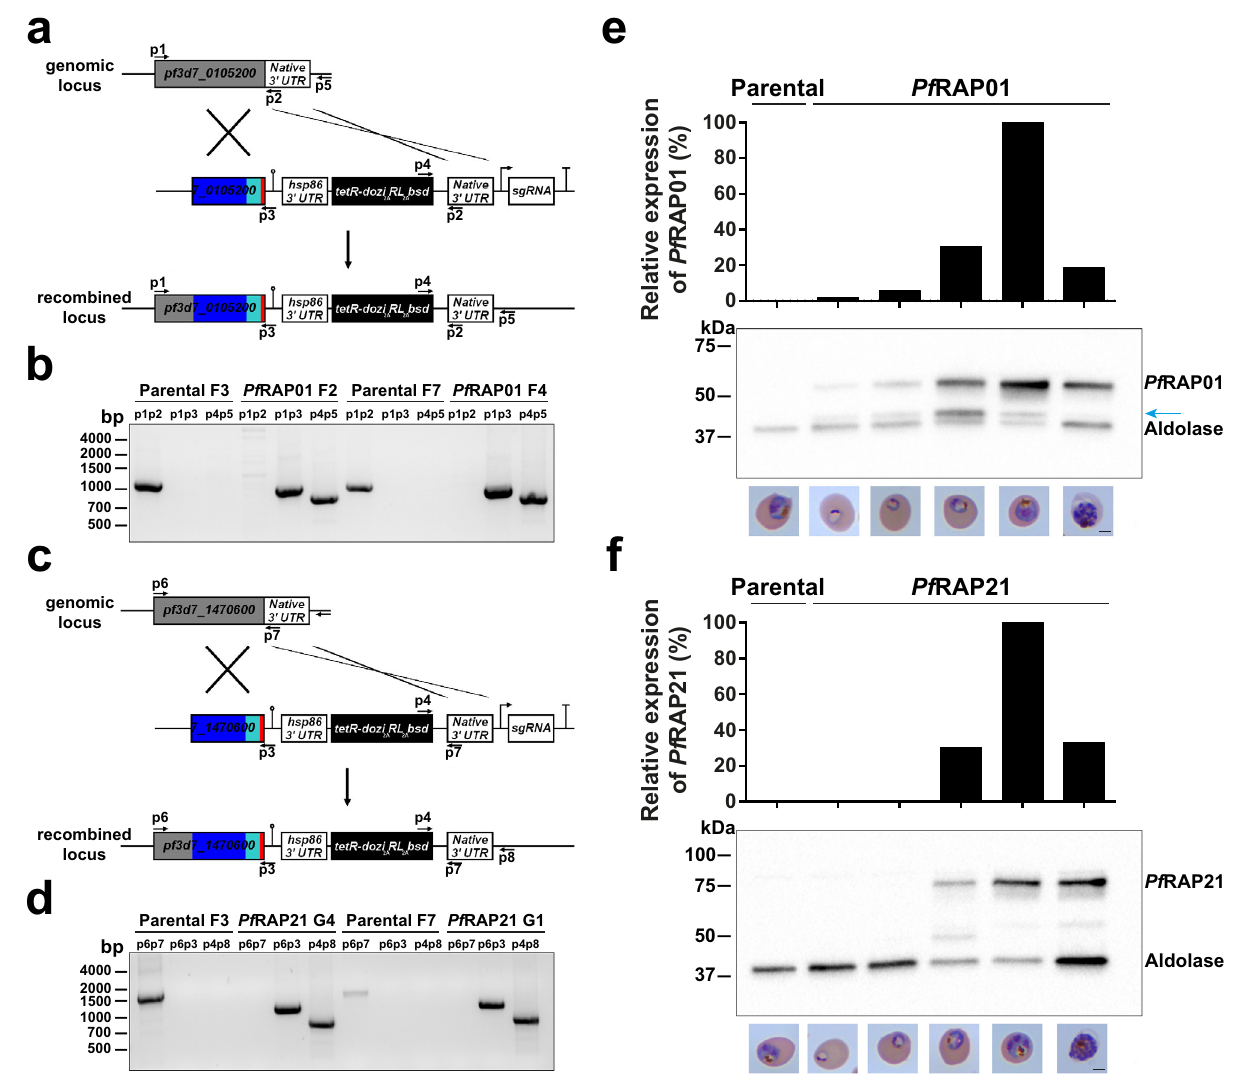
Fig. 1 Validation of Pf RAP01 and Pf RAP21 transgenic lines. Schematic representation of the TetR-aptamer integration strategy into endogenous pf3d7_0105200 ( a ) and pf3d7_1470600 ( c ). TetR-dozi-BSD cassette (black), HA-tag (red), PCR primers, homologous regions used (blue) and recodonized sequences (light blue) are indicated. Genotype analyses of parental, Pf RAP01 ( b ) and Pf RAP21 ( d ) clone lines. PCRs were performed on genomic DNA from indicated lines using different primer combinations. The PCRs are representative of three independent experiments. Immunoblot detection of Pf RAP01 ( e ) and Pf RAP21 ( f ) expression across the asexual blood cycle. The membranes were probed with anti-HA and anti-aldolase was used as loading control. The expression of Pf RAP01 and Pf RAP21 were normalized by aldolase expression. The blue arrow indicates Pf RAP01 degradation. Scale bar: 2 μ m. The immunoblots shown are representative of two independent